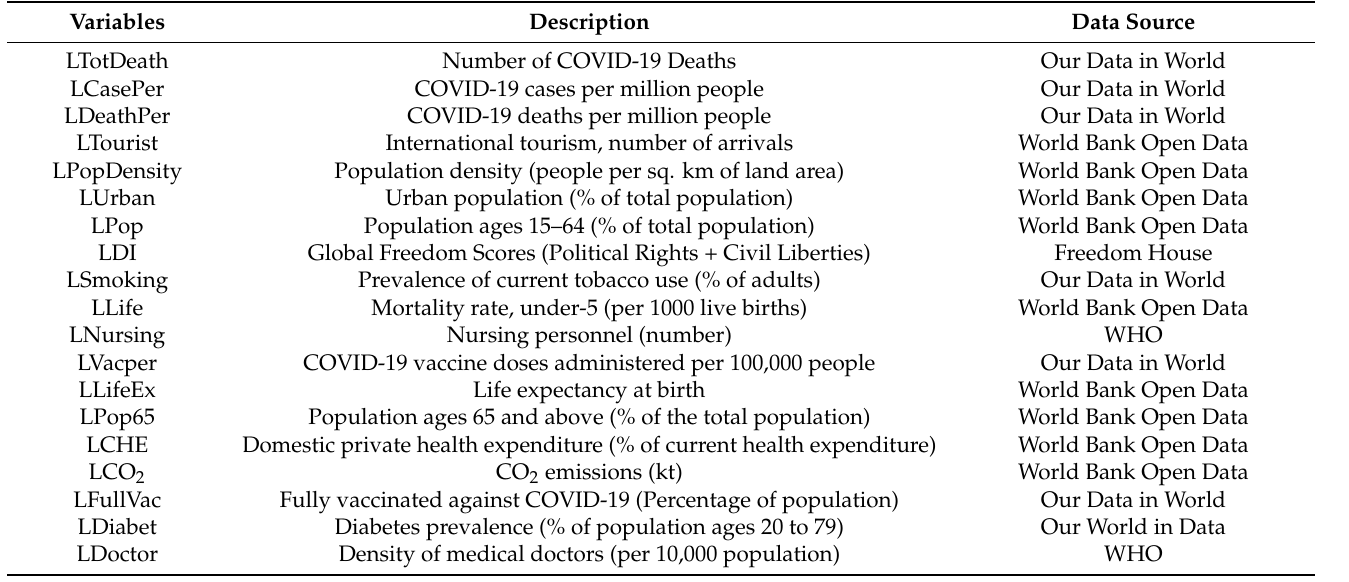
Table 1. Data Description.